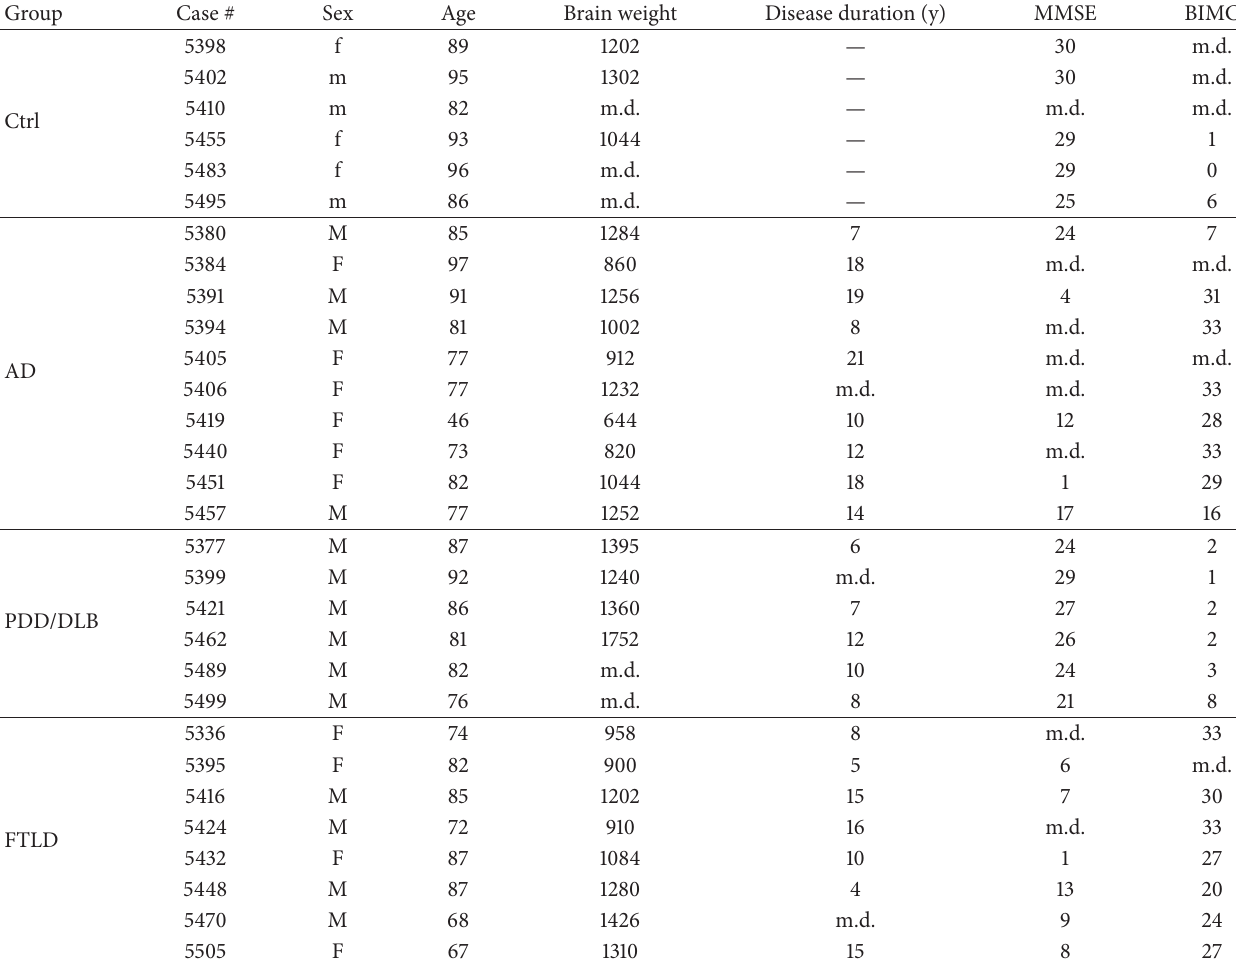
Table 1: Clinical and neuropathological characteristics of subjects